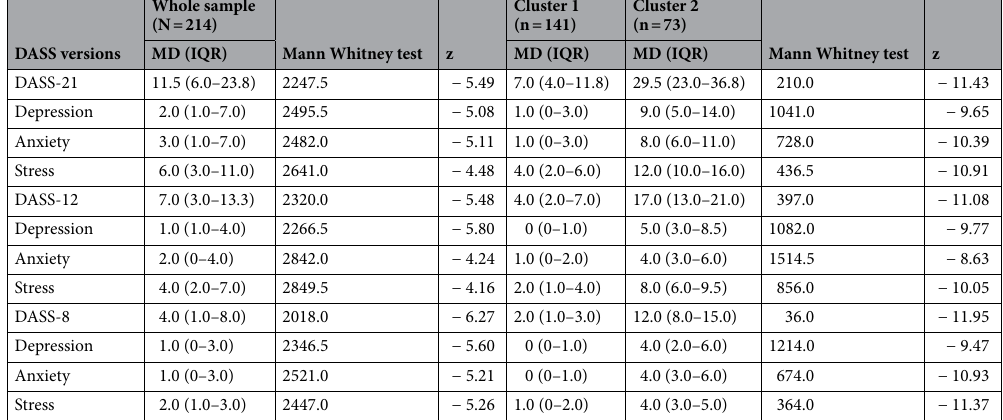
Table 4. Descriptive statistics and discriminant validity of the Depression Anxiety Stress Scale 21 and its shortened versions among women with chronic pelvic pain. DASS: Depression Anxiety Stress Scale, MD: median, IQR: interquartile range, U: Mann Whitney U test, p values were all significant at 0.001 level. For the DASS-21 (N =